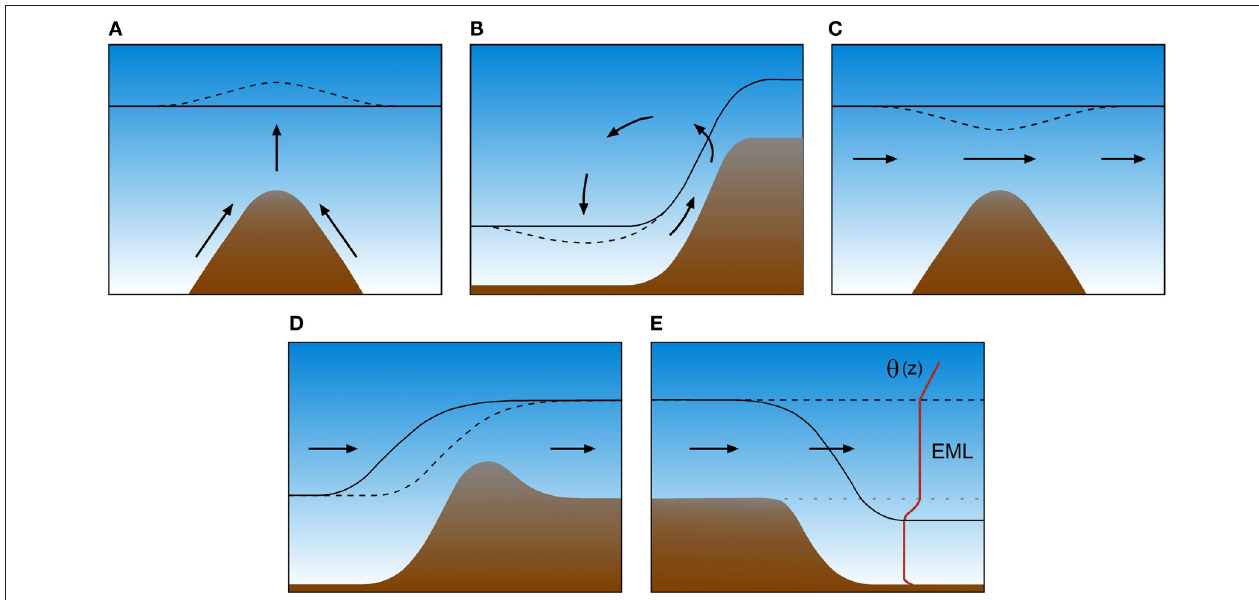
FIGURE 9 | Schematic illustration of advective effects on CBL structure over mountainous terrain. (A) Lifted CBL top over a ridge due to convergence of upslope winds, (B) depressed CBL at a mountain base due to subsiding return circulation of a slope wind system, (C) lowered CBL top over a ridge due to Bernoulli effect, (D) depressed CBL over a ridge due to horizontal advection of a tilted CBL top, and (E) formation of an elevated mixed layer (EML) over a valley due to horizontal advection of a CBL formed over high windward terrain. The solid and dashed black lines indicate the top of the CBL before and after considering the advective effect. Arrows illustrate the